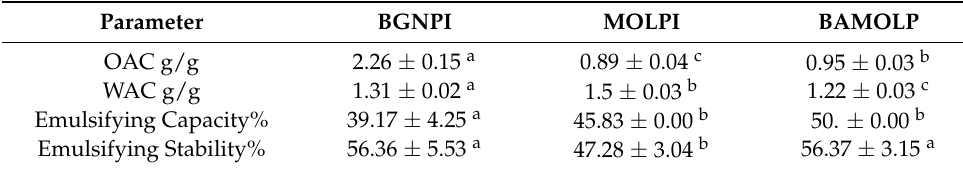
Table 4. Functional properties of BGNPI, MOLPI, and BAMOLP 1